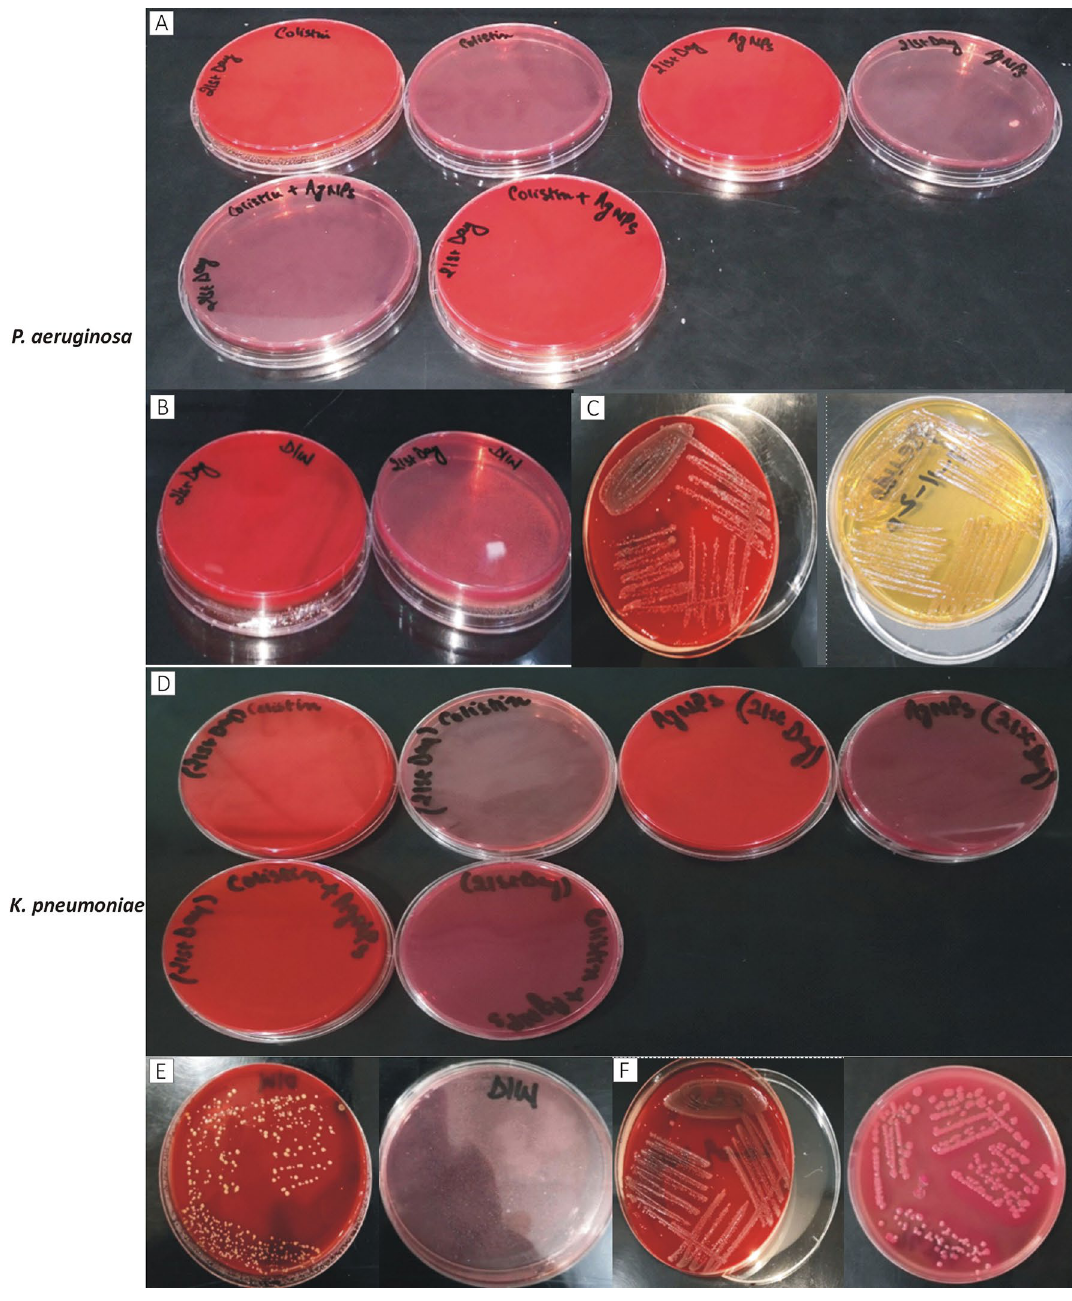
Figure 5. Wound culture of rat wounds on the 21st day. ( A – D ) Treated groups: no growth of bacteria in P. aeruginosa and K. pneumoniae (respectively) cultures, B) no growth of bacteria in negative control of P. aeruginosa , ( E ) growth of S. aureus in negative control of K. pneumoniae , C & F) growth of P. aeruginosa and K. pneumoniae, respectively in their positive controls of culture